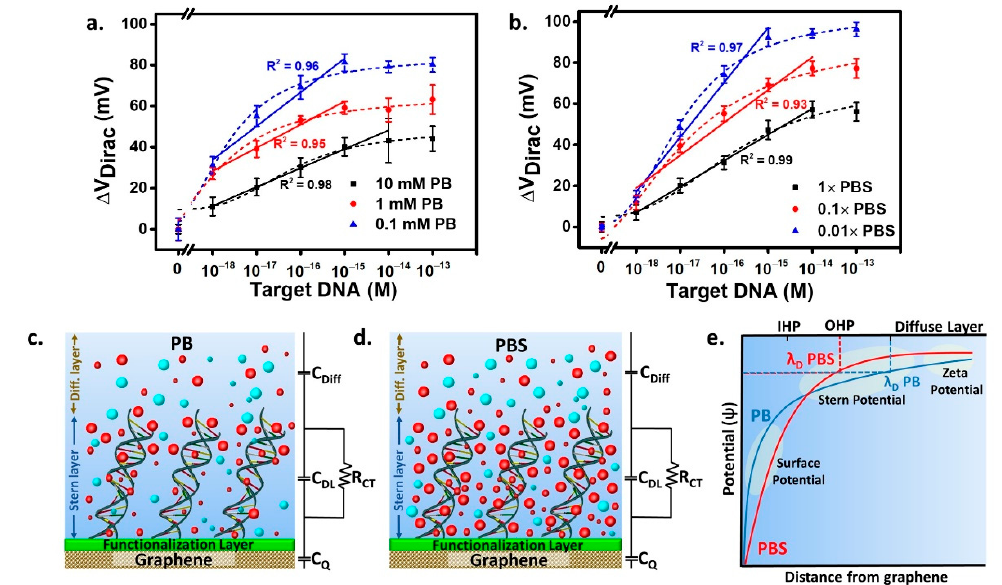
Figure 5. Calibration curves of DNA hybridization detection using a background solution of ( a ) PB, and ( b ) phosphate buffer saline (PBS) with R 2 value corresponds to the linear fitting. Illustration of the ionic gradient on the interface with ( c ) PB, and ( d ) PBS backgrounds and ( e ) The schematic comparison of the electric potential at the interface from the measurement with PB and PBS. The large and small red symbols are positive ions with bigger sizes and smaller sizes, respectively. The large and small cyan symbols are negative ions with bigger and smaller sizes, respectively.